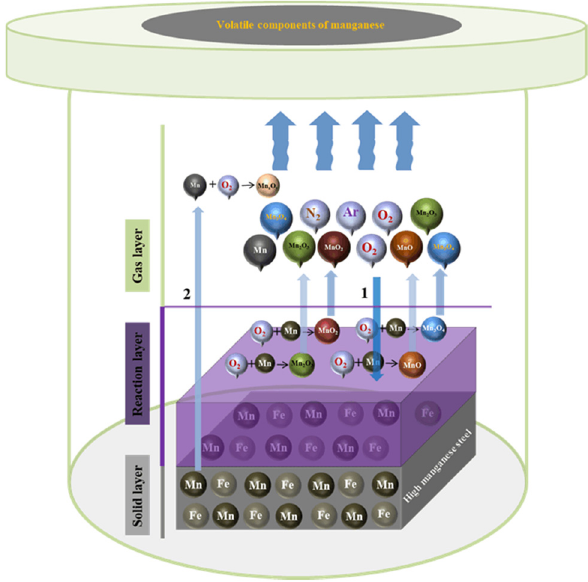
Figure 11: Schematic of manganese volatilization in high manganese